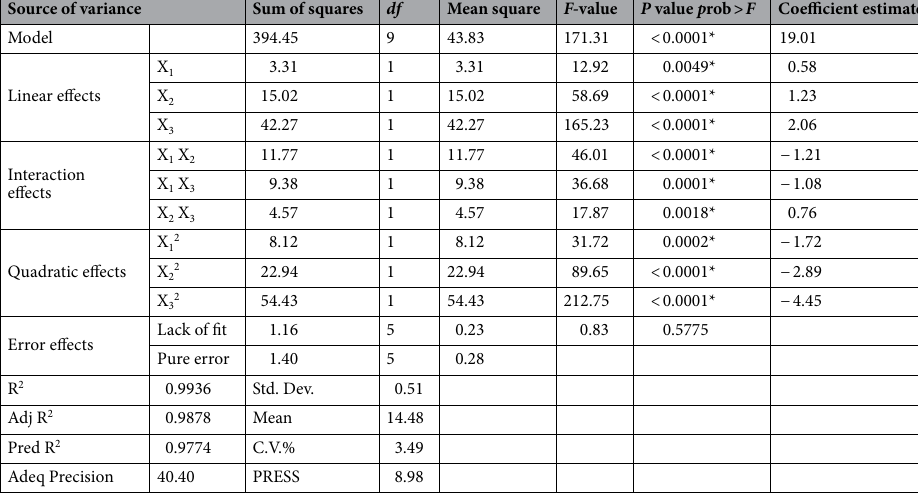
Table 5. Statistical analysis for FCCCD of bacterial nanocellulose production by Bacillus sp . strain SEE-3. The independent factors are: X 1 (pH); X 2 (peptone; g/L); X 3 (Cantaloupe juice; g/L). *Significant values, F : Fishers’s function, P : Level of significance, C.V: Coefficient of